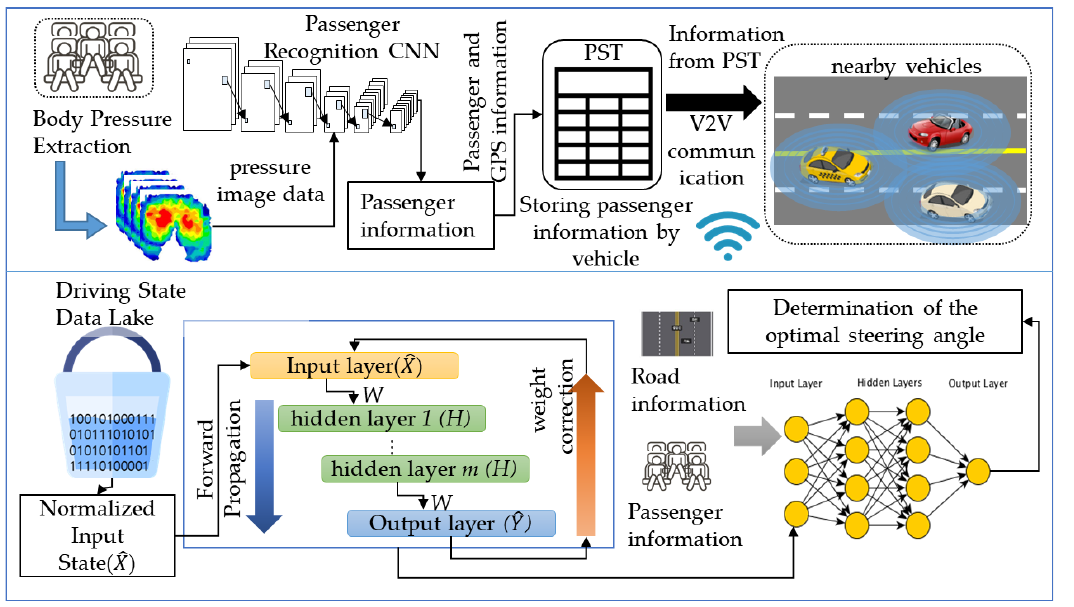
Figure 4. The structure of the PRSM.